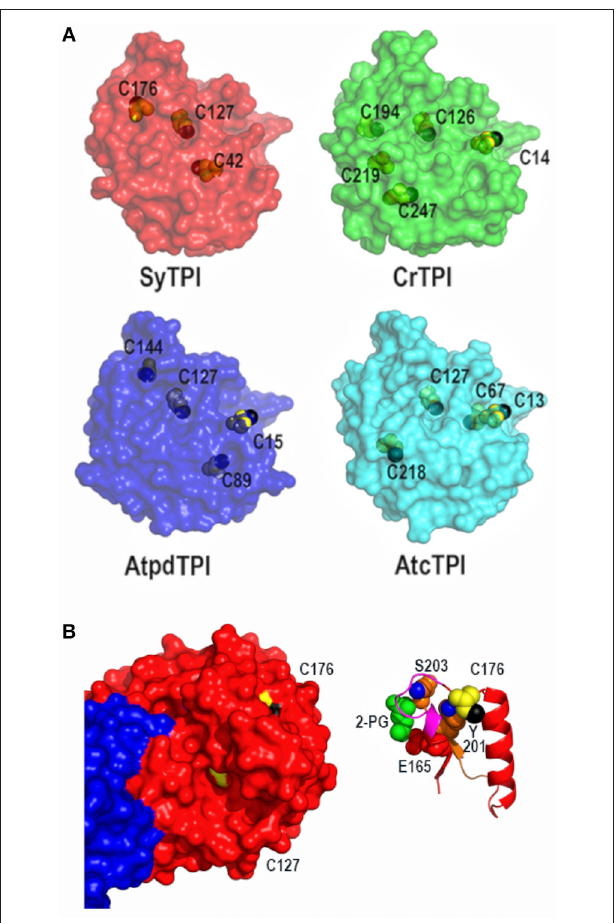
FIGURE 3 | Crystal structure of dimeric SyTPI showing their cysteines. (A) Structural localization of SyTPI cysteines in comparison to the localization of cysteines from photosynthetic organisms (SyTPI, Synechocystis sp. PCC 6803 TPI; CrTPI, C. reinhardtii TPI; AtcTPI A. thaliana cytosolic TPI; AtpdTPI A. thaliana chloroplastic TPI). (B) Structural localization of SyTPI-C176. (Left) Surface representation of Subunits A and B of SyTPI colored in blue and red. All cysteine residues are colored in yellow. The thiol group of C127 points toward the hydrophobic core (black colored), whereas the thiol group of C176 is solvent exposed (black colored). (Right) Ribbon representation centered around C176. The side chain of residue C176 interacts with residues Y201. The hydroxyl group of Y201 (blue colored) and main chain of residue S203 stablishes van der Waals interactions with C176. Residues Y201 and S203 assemble the phosphate binding loop (loop 6).